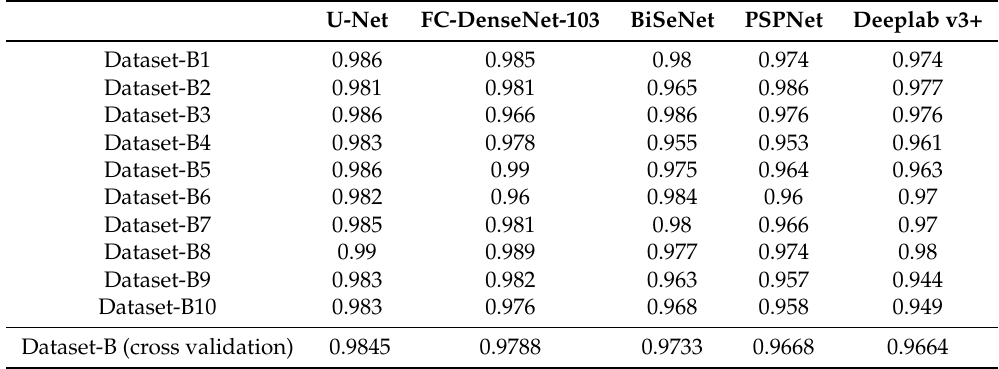
Table 9. Average Accuracy measured for every algorithm on Dataset-B (cross-validation).